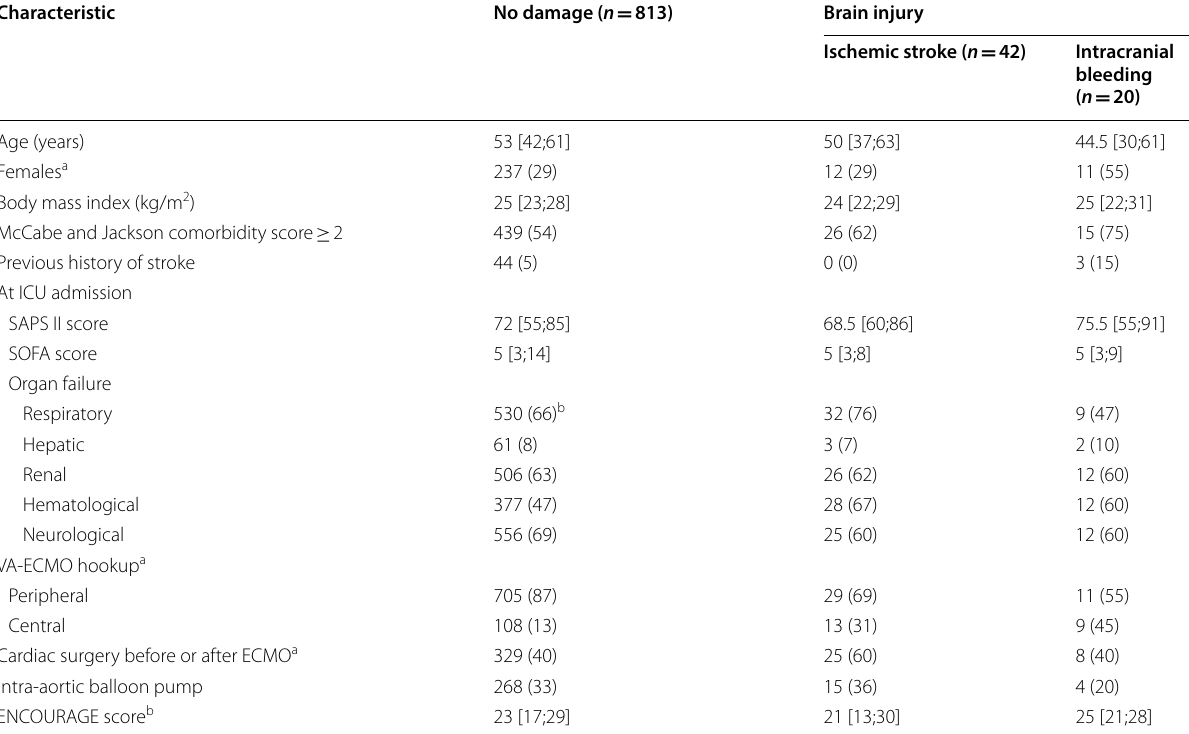
Results are expressed as number (%) or median [27th;75th percentile] SAPS Simplified Acute Physiology Score, SOFA sequential organ failure assessment, VA-ECMO venoarterial-extracorporeal membrane oxygenation a P < 0.05 for between-group comparisons